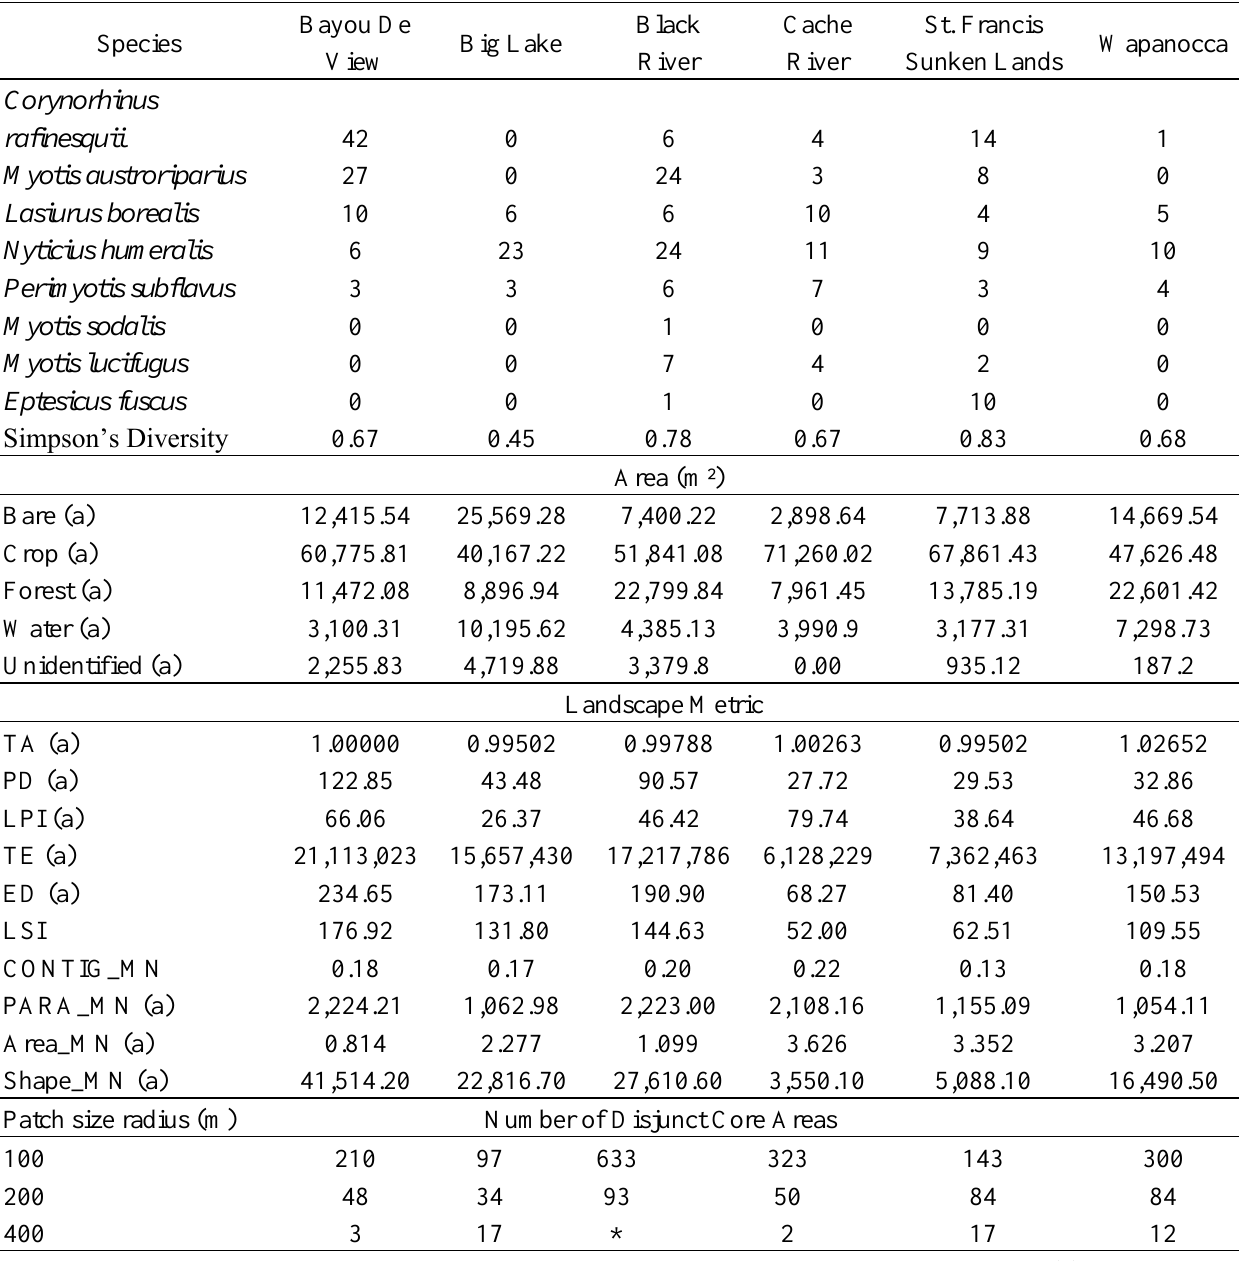
“a” indicates subset correction to target value by a translation equation (adjusted value (a) = target (ha)/subset area (ha) × observed metric value (ha) × Indicates model failure. TA = total area; PD = patch density; LPI = length to perimeter index; TE = total edge; ED= edge